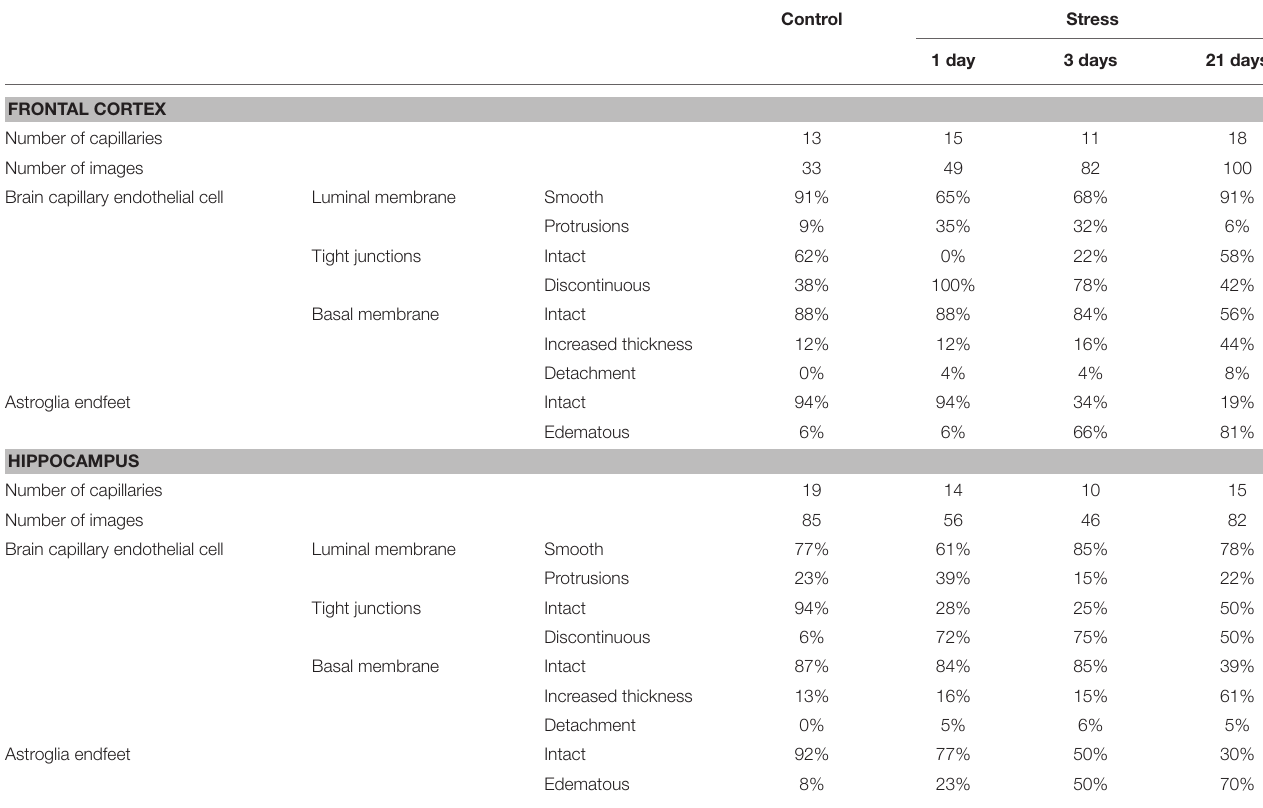
TABLE 1 | Summary of changes in BBB ultrastructure following restraint stress in adult